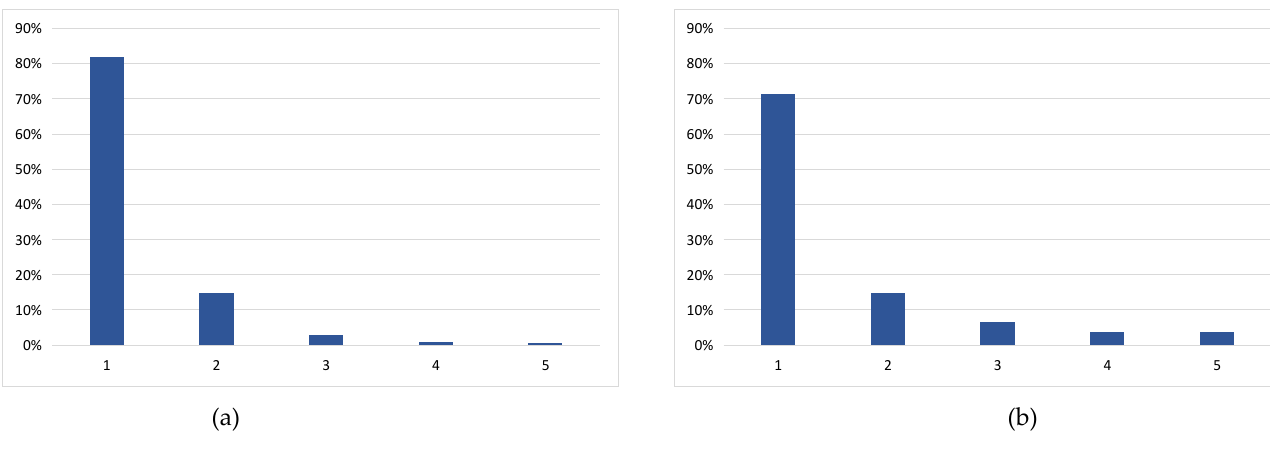
Figure 2. Proportions of number distributions of points in one voxel for the ( a ) KITTI set and ( b ) ONCE set. The x- and y-axes represent the number of points in a voxel and the proportion of this ( b ) ONCE set. The X- and Y-axes represent the number of points in a voxel and the proportion of this type of voxel among all the voxels, respectively. type of voxel among all the voxels,